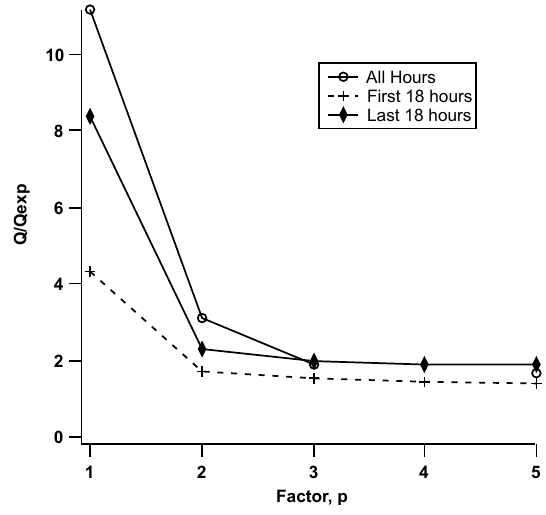
Fig. A8. Q/Q exp vs. p for 3 types of